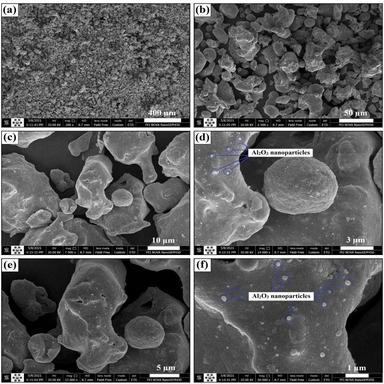
FE-SEM images show (a-c) the morphology and size distribution for the S316-L stainless steel micron size powder and (d-f) decorated Al2O3 nanoparticles on their surface.